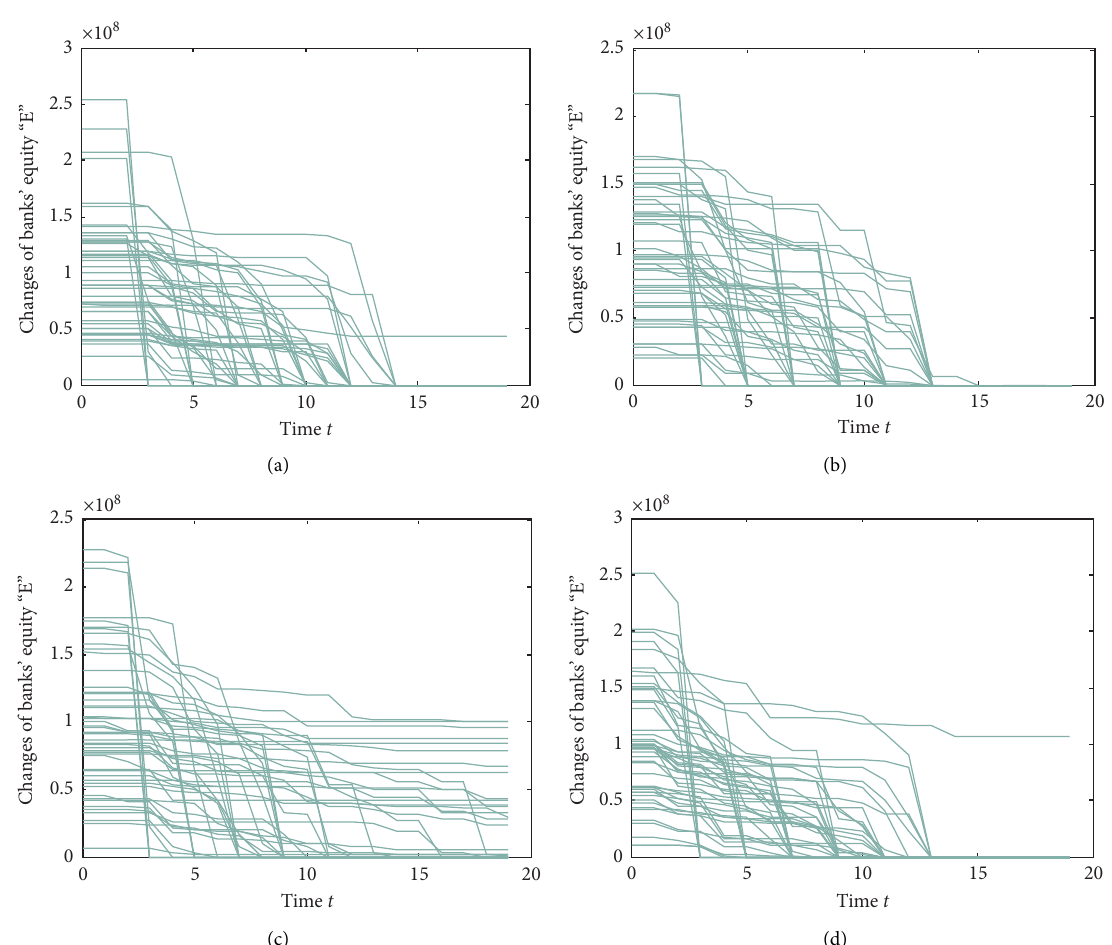
Figure 4: Losses of banks’ equity over time influenced by nodes’ different initial distress status.